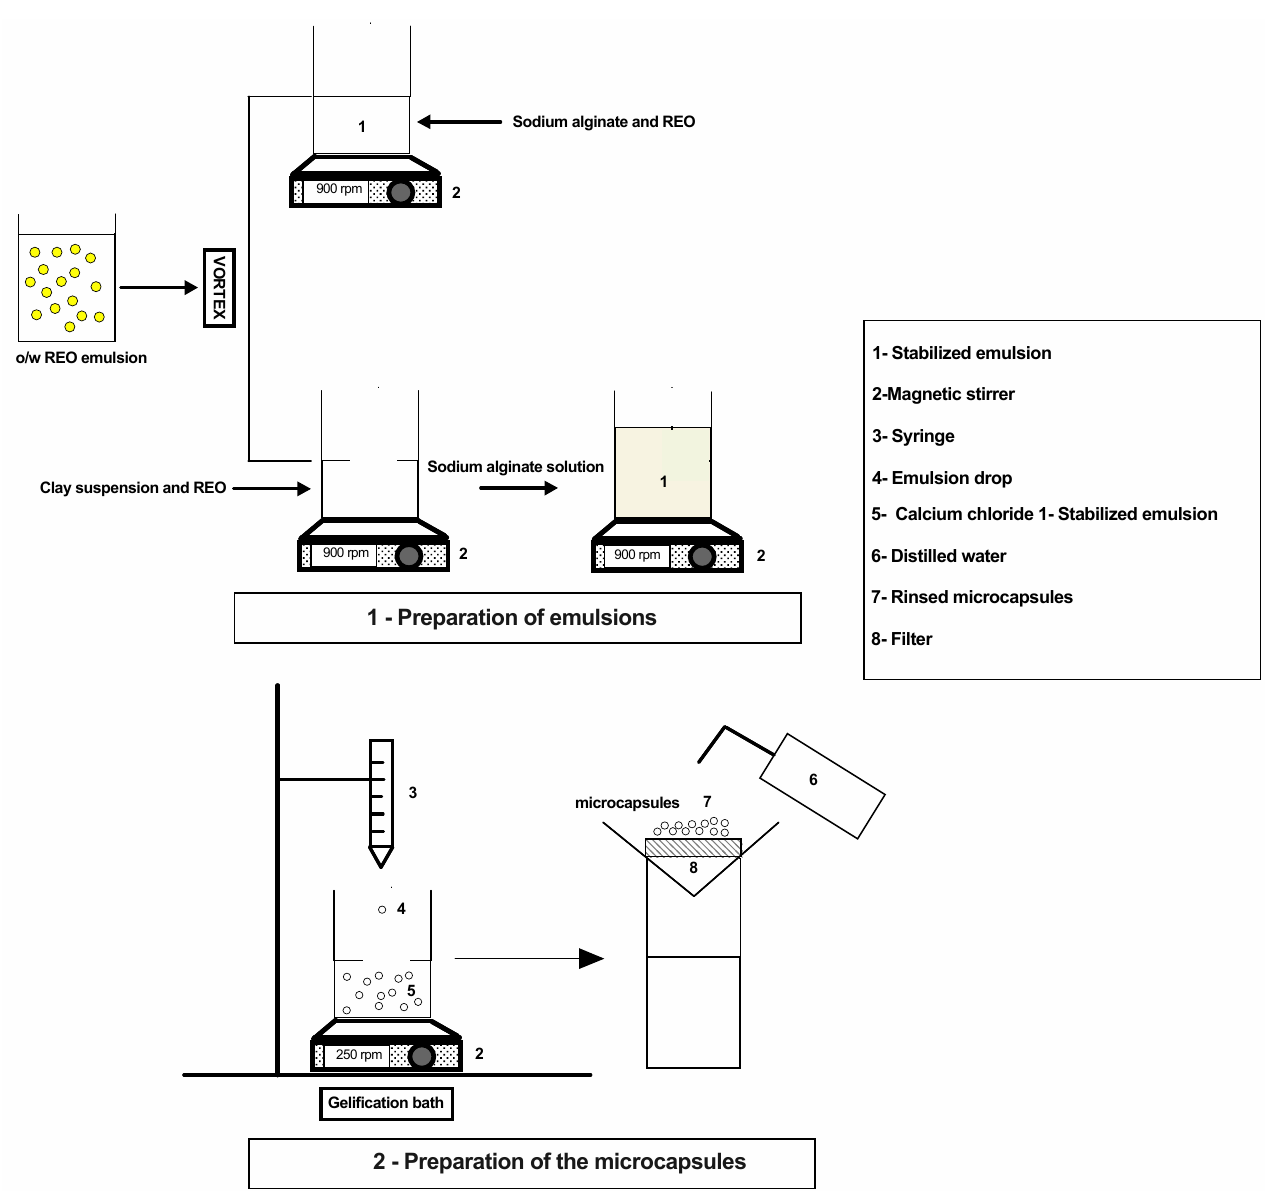
Figure 1. Illustration of the CA and hybrid CA-MTN microcapsules elaboration process. For calcium alginate CA microcapsules, a sodium alginate solution (1% w / v ) was dissolved in distillate water while being stirred magnetically (350 rpm) at room temperature (20 °C). An oil/water emulsion was formed by mixing REO with sodium alginate solution and left to stir overnight to reach a final concentration of 1, 2 and 3% of rosemary essential oil. For the CA-MTN hybrid microcapsules, a dispersion of sodium bentonite MTN (4%) in distillate water was left to stir overnight. Different concentrations of rosemary essential oil (1, 2 and 3%) were added to the sodium bentonite dispersion and left to stir overnight for the maximum adsorption of essential oil on the bentonite. The sodium MTN/REO emulsion was then blended with sodium alginate solution with a 1:2 ratio and left to stir for 5 h. The amount of alginate solution and bentonite dispersion used in hybrid CA-MTN microcapsules were calculated to obtain the same final essential oil concentration as in CA microcapsules. The CA and CA-MTN hybrid microcapsules were generated by adding the emulsions dropwise to calcium chloride solution (0.1 M) for 60 min under magnetic stirring. The microcapsules were retrieved through filtration, repeatedly rinsed with dis- tilled water and then put into storage at 4 °C.